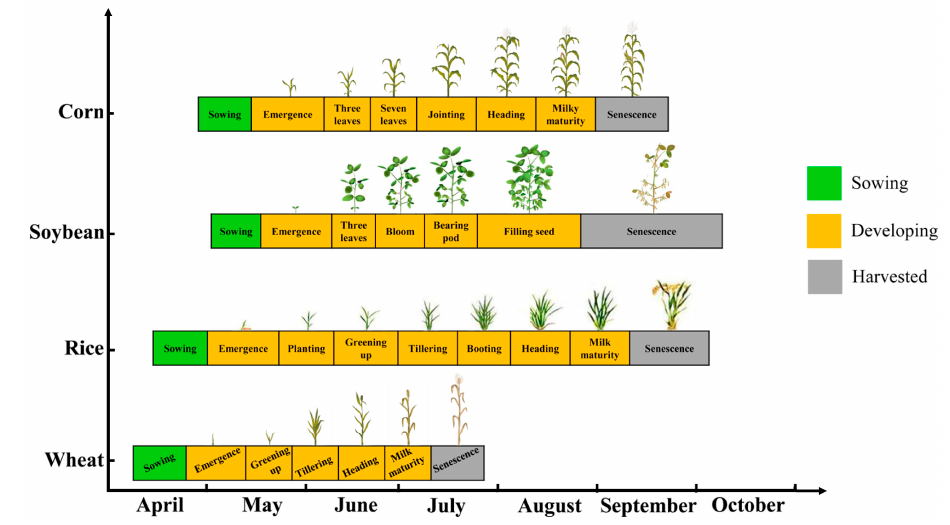
Figure 2. Crop calendars in Beian City, Heilongjiang Province. Table 1. Targeted crop types and associated number of training and validation samples at different crop growing phrases in